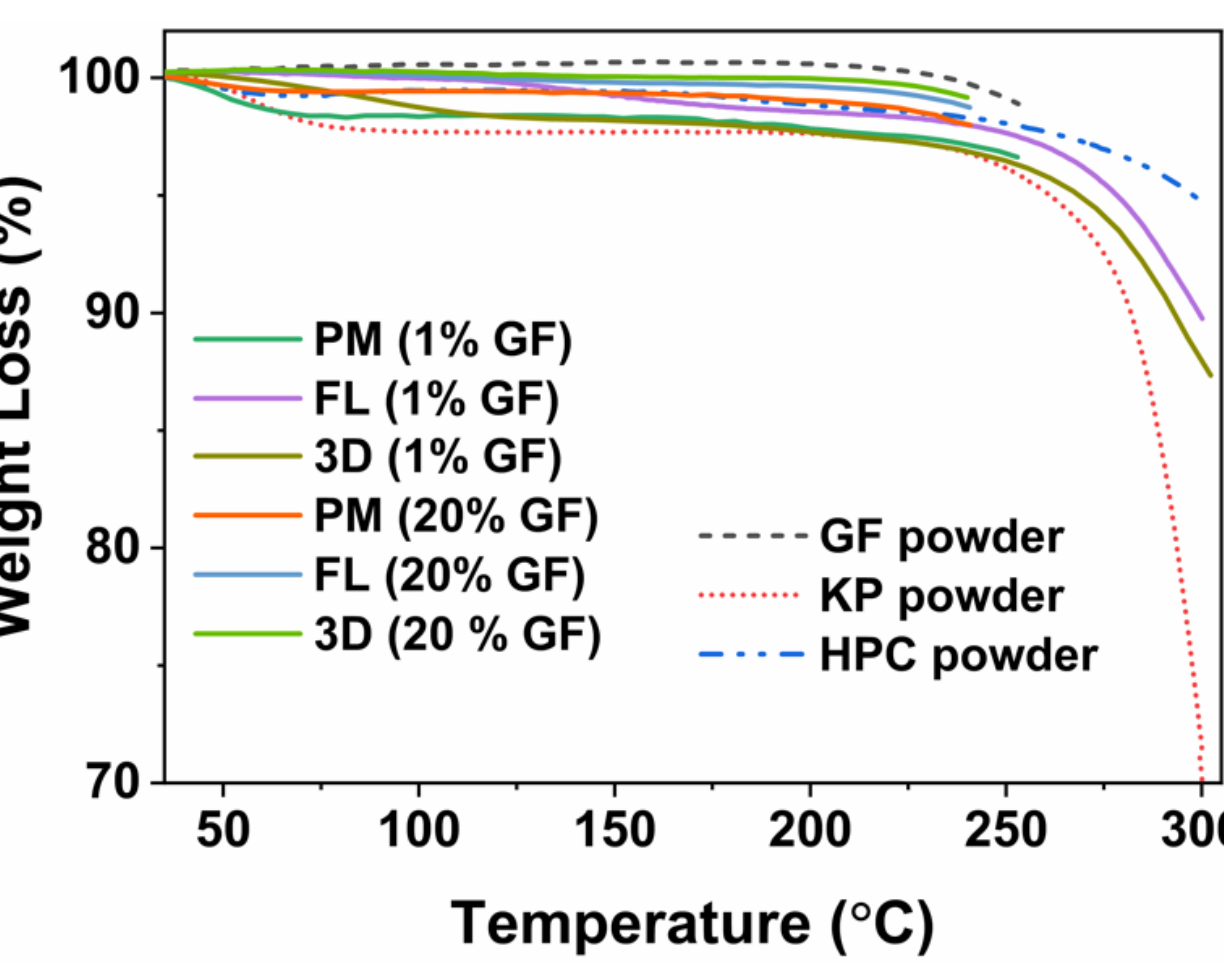
Figure 2. TGA thermograms for GF, HPC and KP powders, physical mixtures (PMs), filaments, and printed tablets at 1.0 and 20.0 wt% drug concentrations.